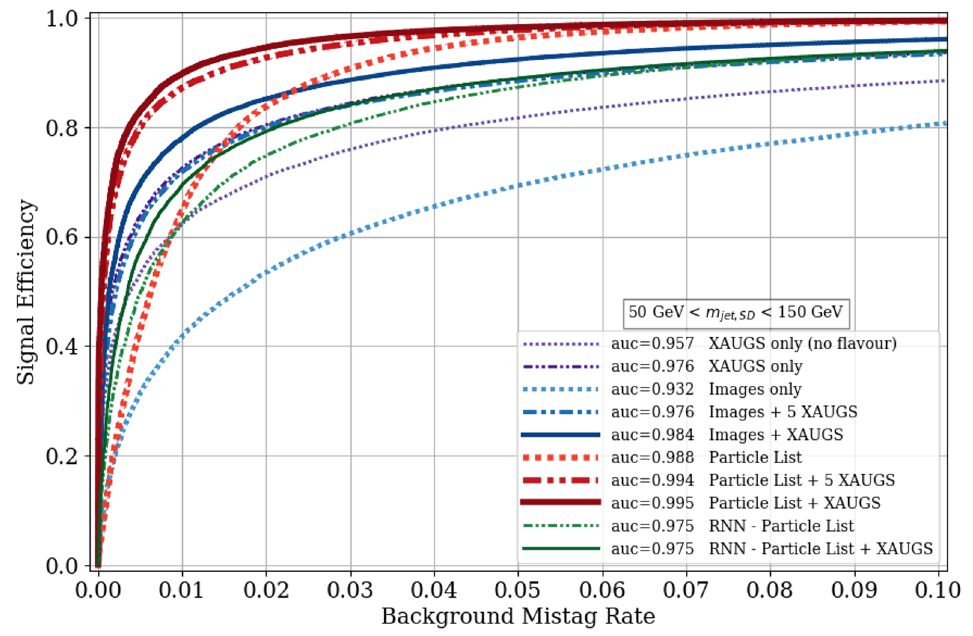
JHEP05(2021)208